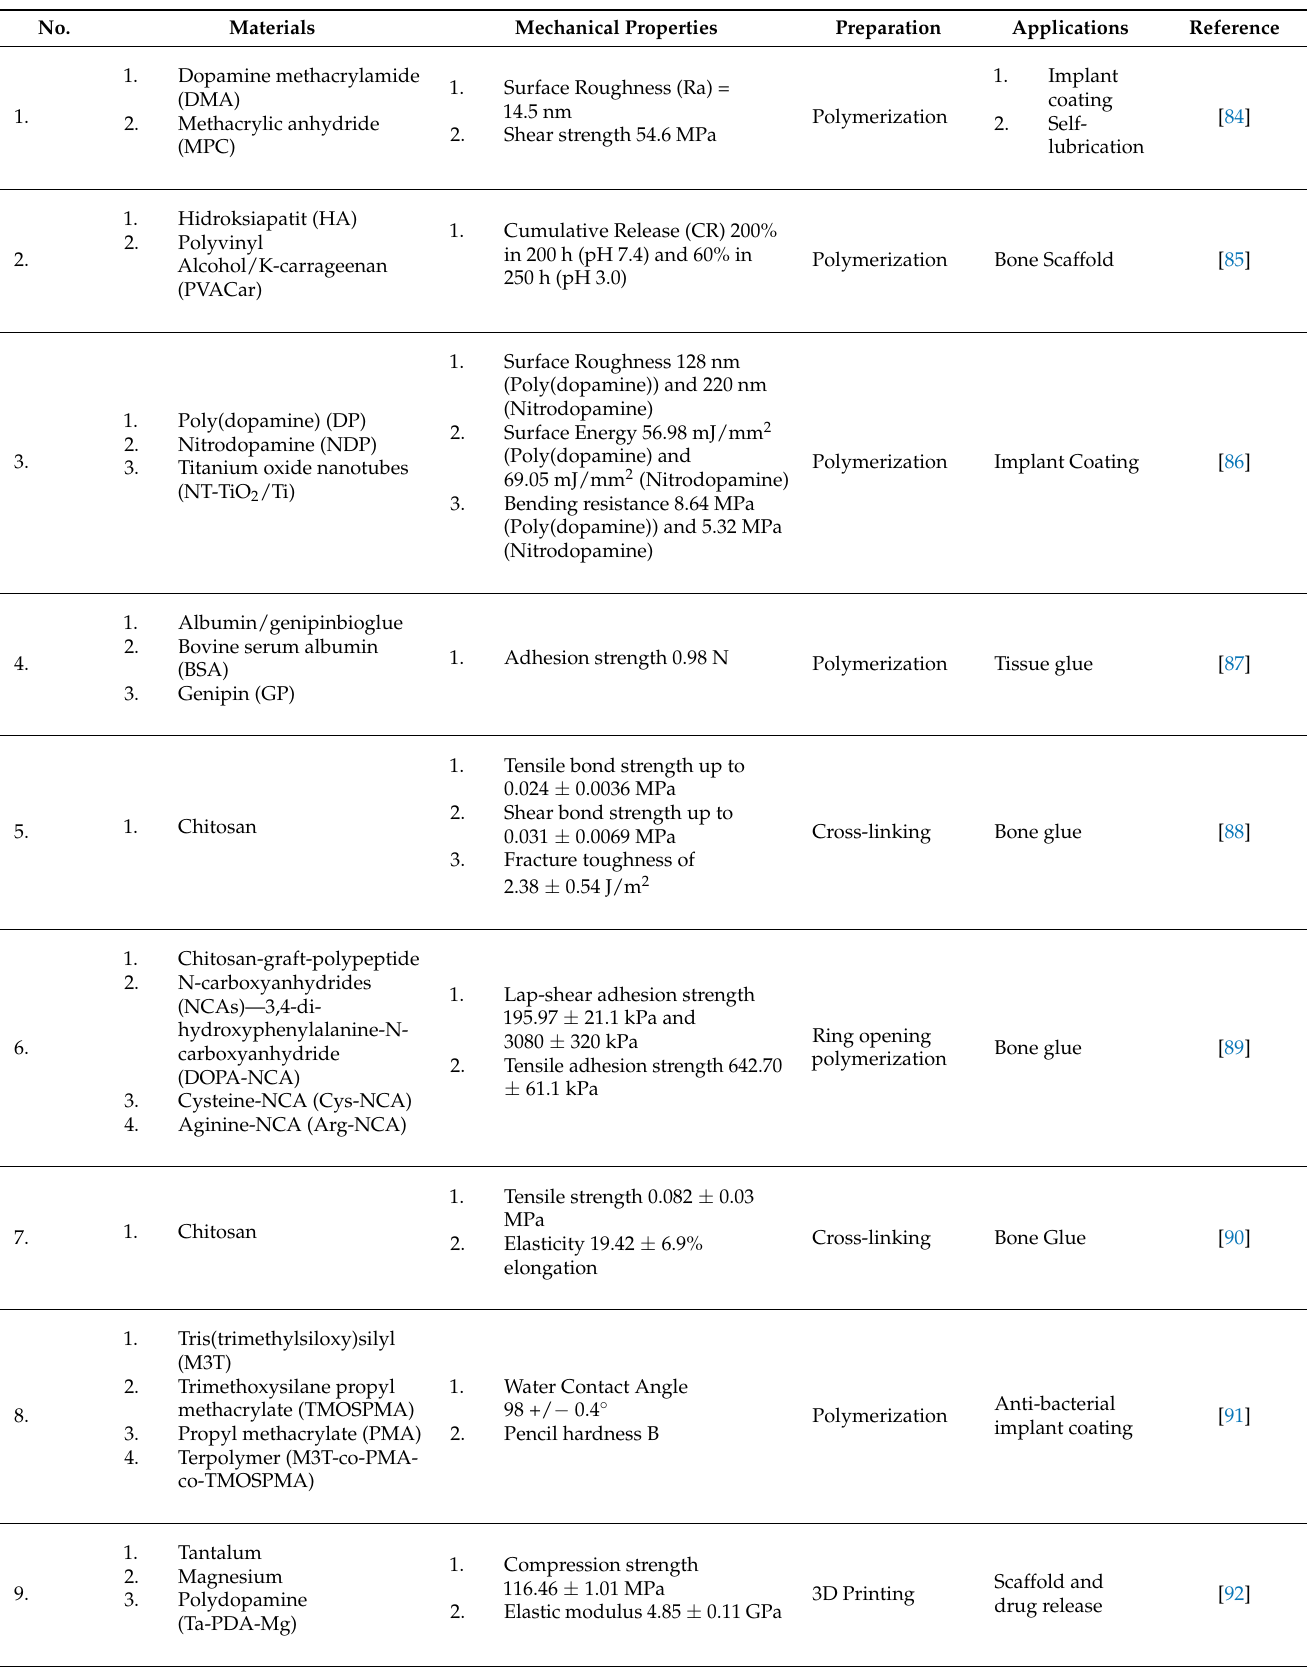
Table 1. Summary of Bio-Adhesive Source, Materials, Preparation, and